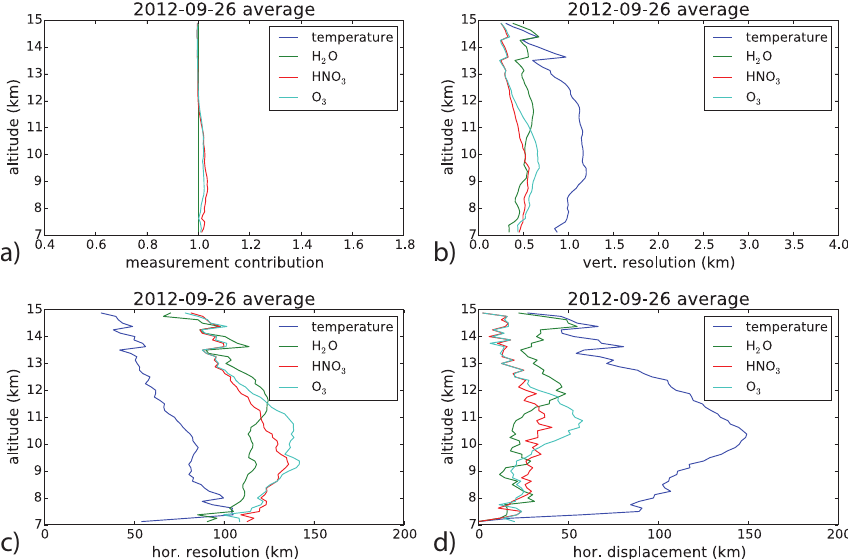
Figure 5. Diagnostic quantities for the four primary targets averaged over the profiles of the flight of 26 September 2012: measurement contribution (a) , vertical resolution (b) , horizontal resolution (c) , and horizontal displacement (d) . Horizontal resolution and displacement have been computed using the band model; displacement is measured relative to the tangent point location. The resolution is defined as the “full width at half max” of the corresponding row of the averaging kernel